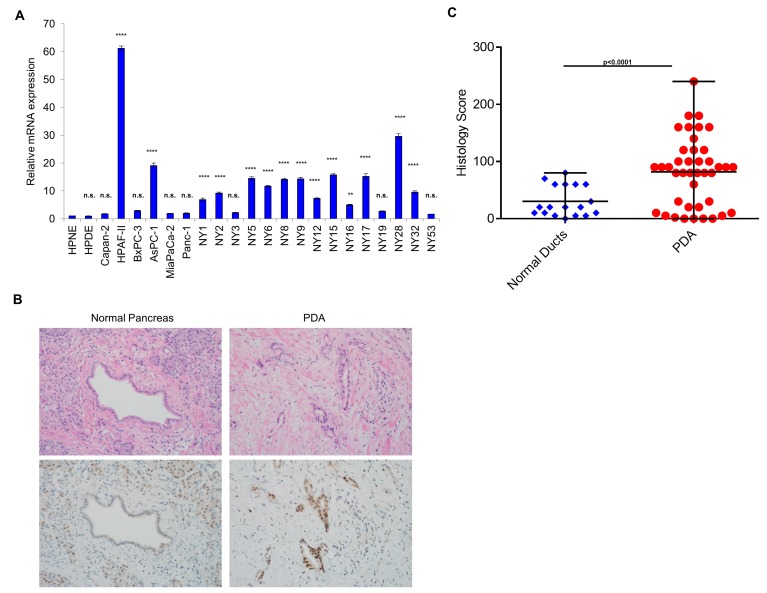
HNF1A expression in PDA cells and patient samples.(A) qRT-PCR analysis of HNF1A mRNA expression in a panel of conventional and primary PDA lines. HNF1A mRNA expression was normalized to an ACTB internal control and relative to HPNE. Relative HNF1A mRNA expression is indicated as a mean ± SEM, (n = 3). Statistical difference was determined by one-way ANOVA with Dunnett’s multiple comparisons test using HPNE as the control group. n.s. = non significant, *p<0.05, **p<0.01, ***p<0.001, ****p<0.0001. (B, C) A pancreatic cancer tissue microarray (TMA) consisting of 41 PDA samples and 18 normal pancreas controls was immunostained for HNF1A. Representative hematoxylin and eosin staining and HNF1A staining of normal pancreas and PDA are shown in (B). Histology scores (HNF1A staining intensity x % HNF1A positive cells) for normal pancreatic ducts (n = 18) versus PDA (n = 41) is shown in (C). Statistical difference was determined by unpaired t test with Welch's correction.